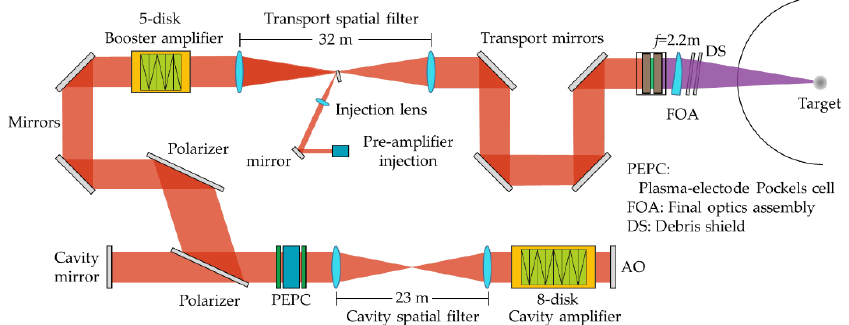
Figure 1. Layout of the SG-II UP facility.